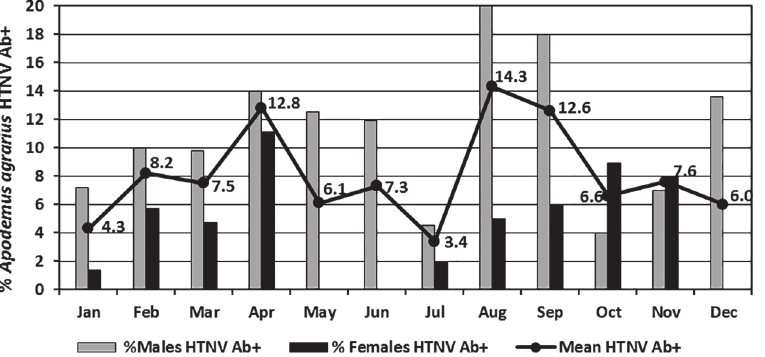
Crocidura lasiura , were seropositive for hantaviruses (not included).